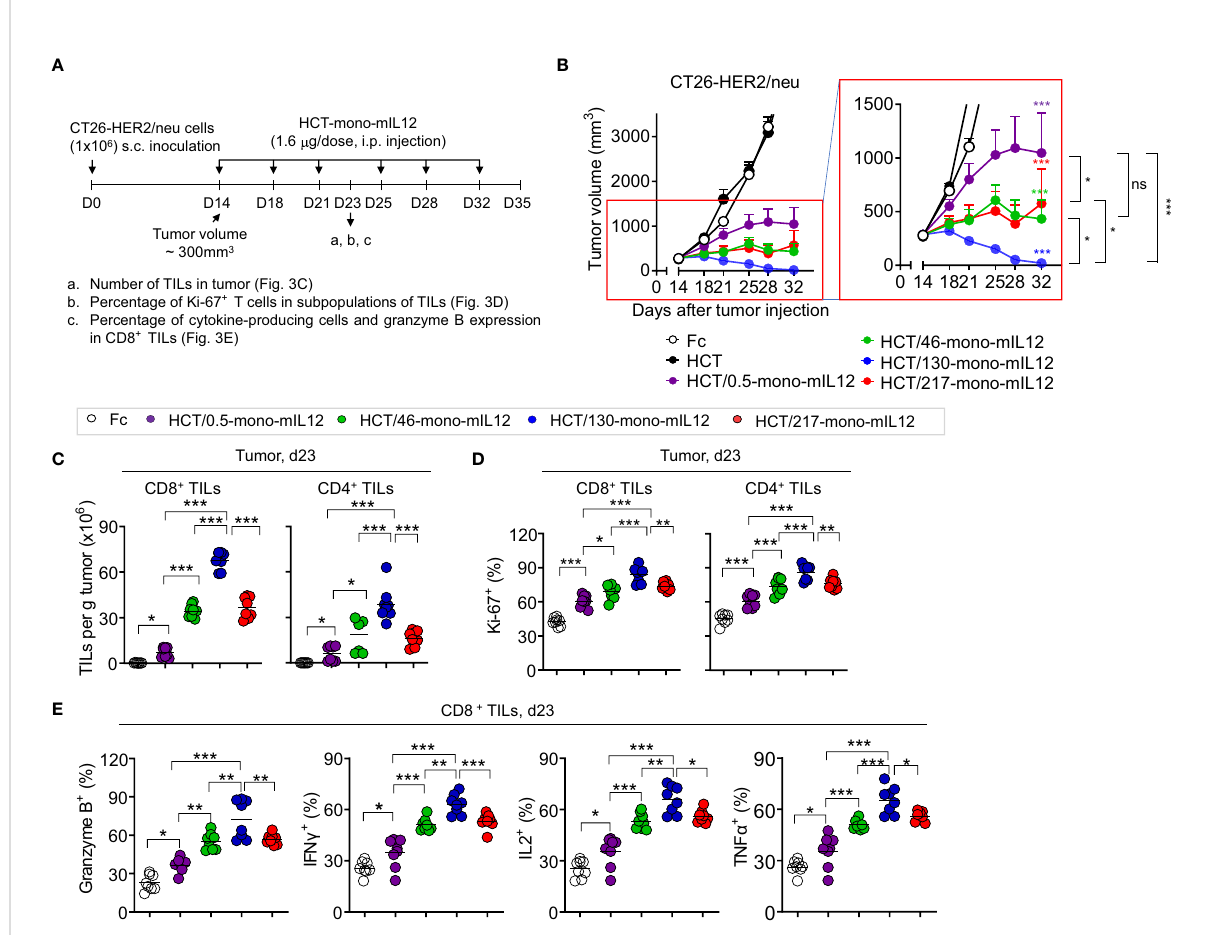
FIGURE 3 In vivo antitumor ef fi cacy of HCT-mono-mIL12 varies according to its anti-HER2 binding kinetics. (A – E) Treatment scheme of BALB/c mice bearing a single- fl ank tumor of CT26-HER2/neu cells initiated at a tumor volume of ~300 mm 3 with i.p. injection of HCT-mono-mIL12 at 1.6 m g per dose (an equimolar amount of 0.5 m g rmIL12 per dose) twice weekly (A) to determine the antitumor activity (B) and its effect on the number and function of CD4 + and CD8 + TILs (C – E) assessed on day 23 after tumor inoculation [see a – c of (A) ]. In (A) , the arrows indicate each time point for the treatment or assay. In (B) , data represent means ± SEM (n = 14 per group). The region boxed in red is enlarged to the right to better visualize the differences in the antitumor activity among HCT-mono-mIL12 variants. (C – E) Number of CD4 + and CD8 + TILs (C) and percentage of Ki-67-expressing (D) and cytokine-producing or granzyme B-expressing cells (E) among CD4 + and/or CD8 + TILs in the CT26- HER2/neu tumor-bearing mice analyzed by fl ow cytometry. In (C – E) , each symbol represents the value obtained from individual mice (n ≥ 8 per group), and midlines represent the means of two pooled experiments. In (B – E) , *p < 0.05, **p < 0.01, ***p < 0.001 between the indicated groups as determined by one-way analysis of variance with the Newman-Keuls post-hoc test; ns, not signi fi cant. Data are pooled from two independent experiments with at least four mice per